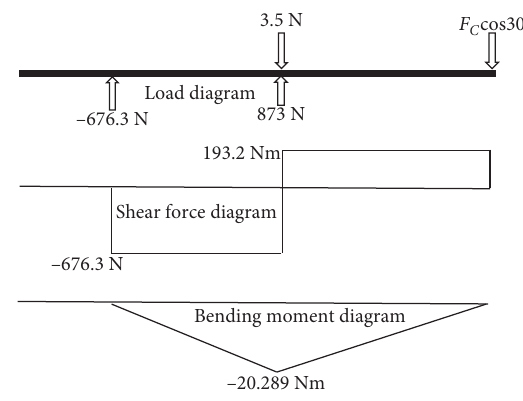
Figure 7: Load, shear force, and bending moment diagrams of the upper